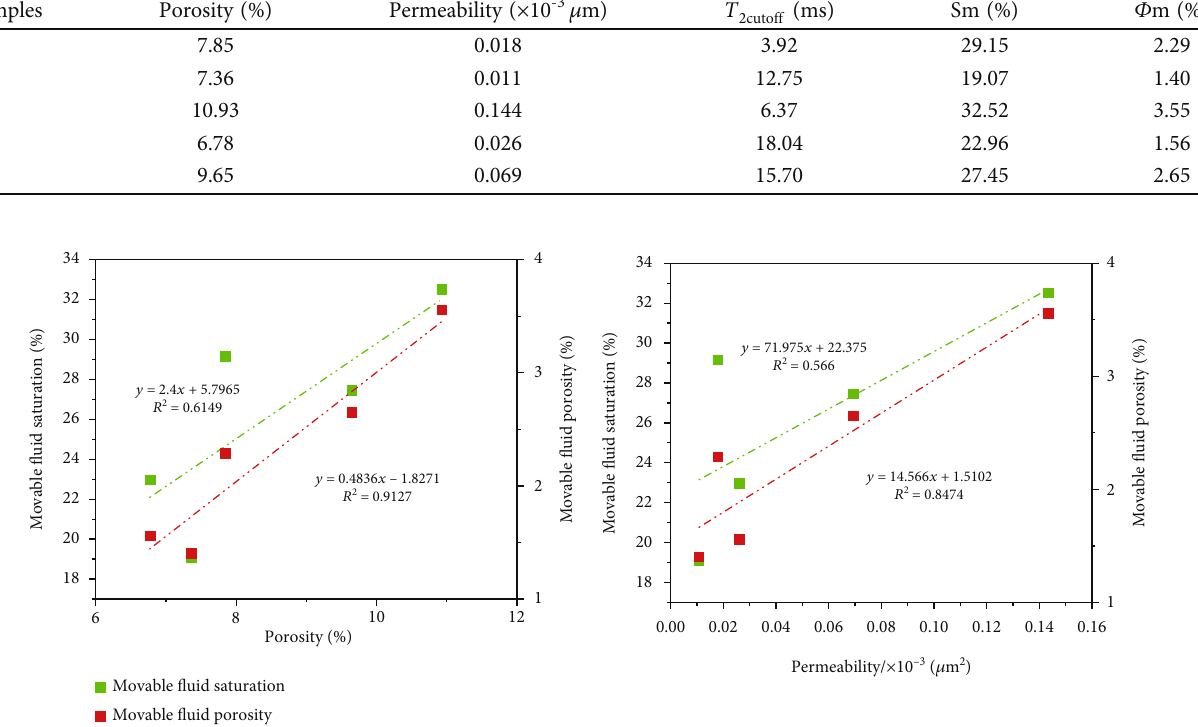
Figure 6: Correlation of movable fl uid parameters with their physical